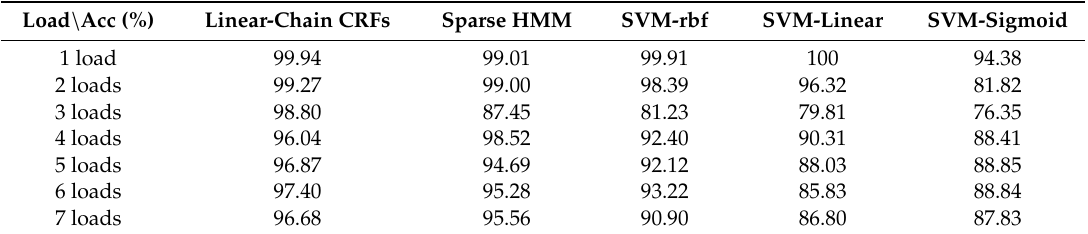
Table 4. Accuracy comparison between the linear-chain CRF model and other algorithms. Load \ Acc